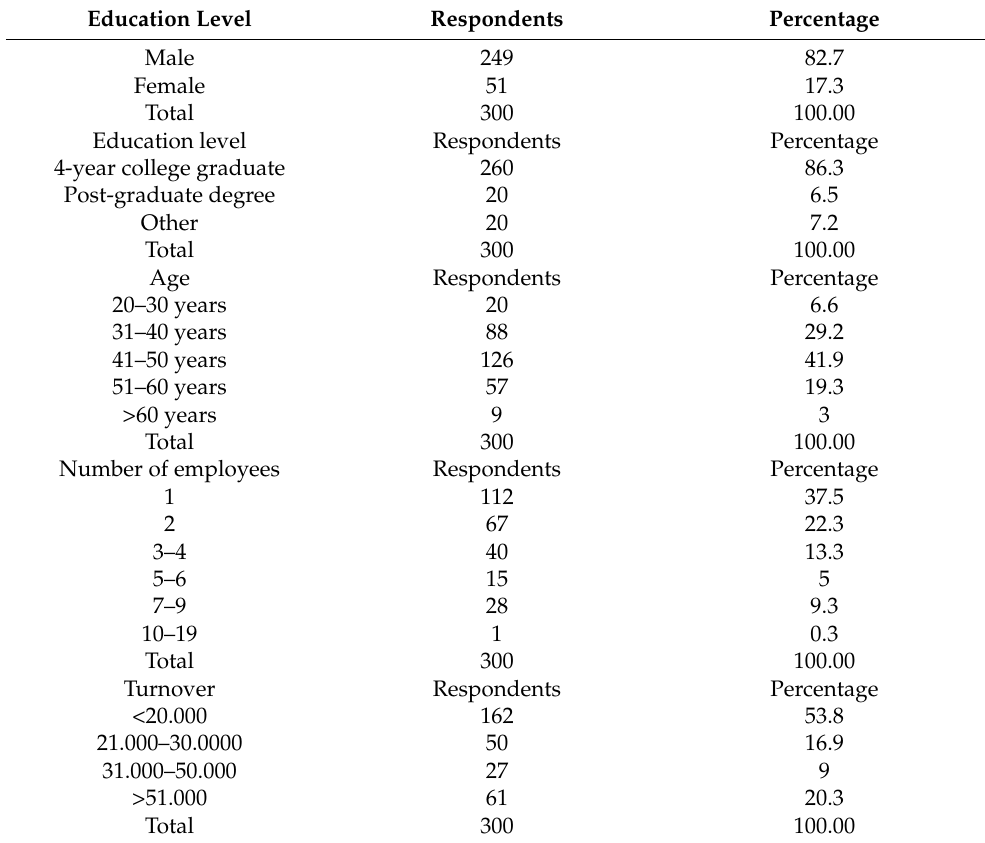
Table 1. Demographic